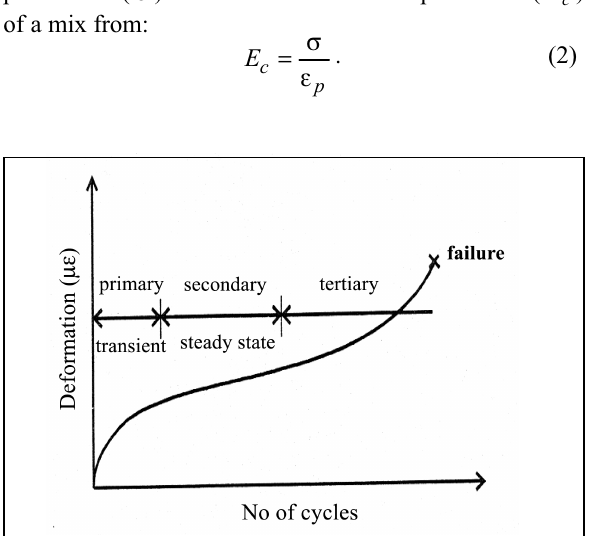
Fig 1. Performance of a typical mix